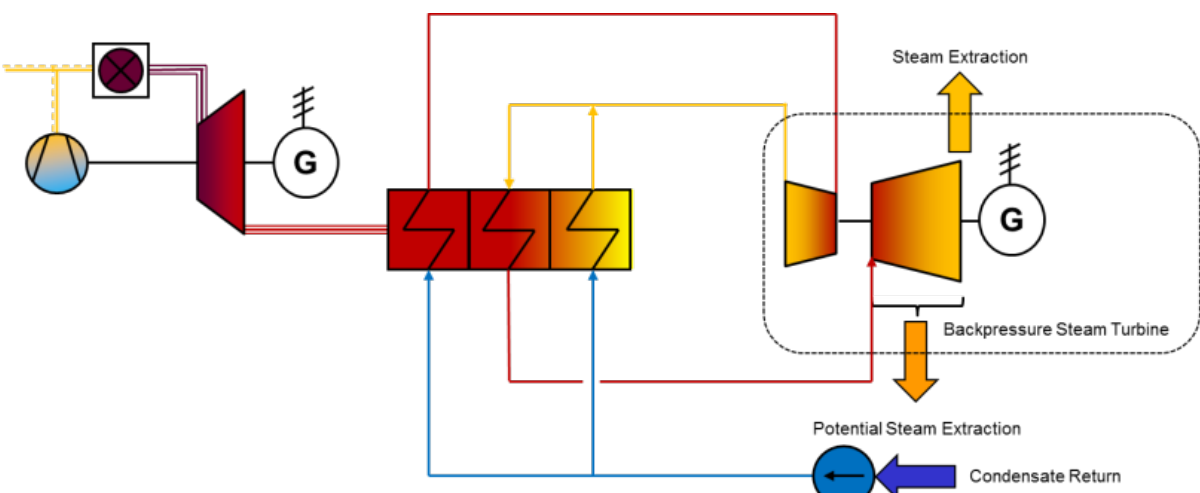
Figure 6. Backpressure Double Pressure Reheat CHP Cycle